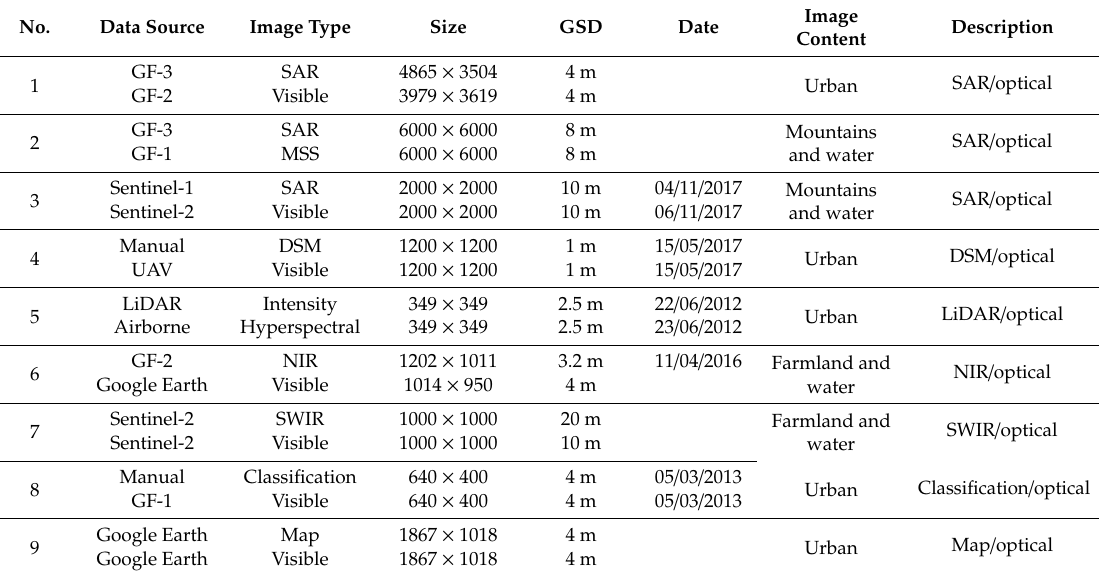
Figure 9. Feature point matching for the real multimodal remote sensing image pairs. Table 3. The real